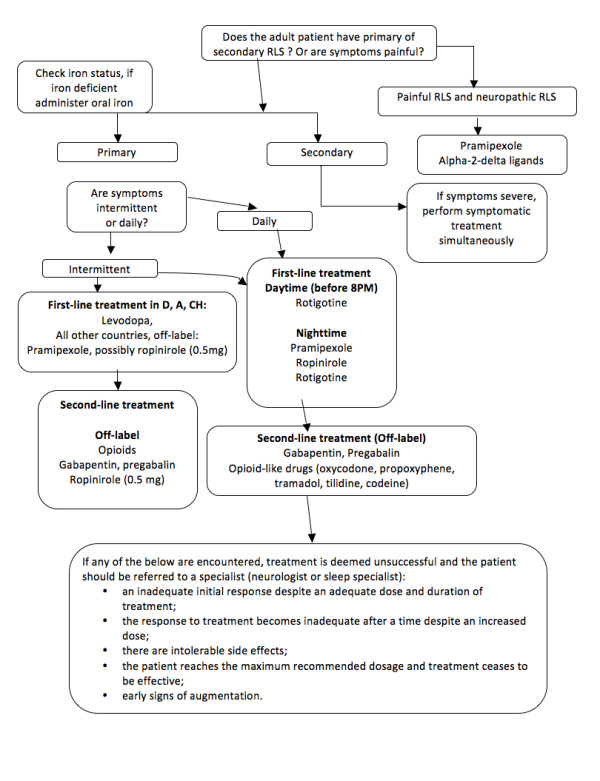
Treatment algorithm.